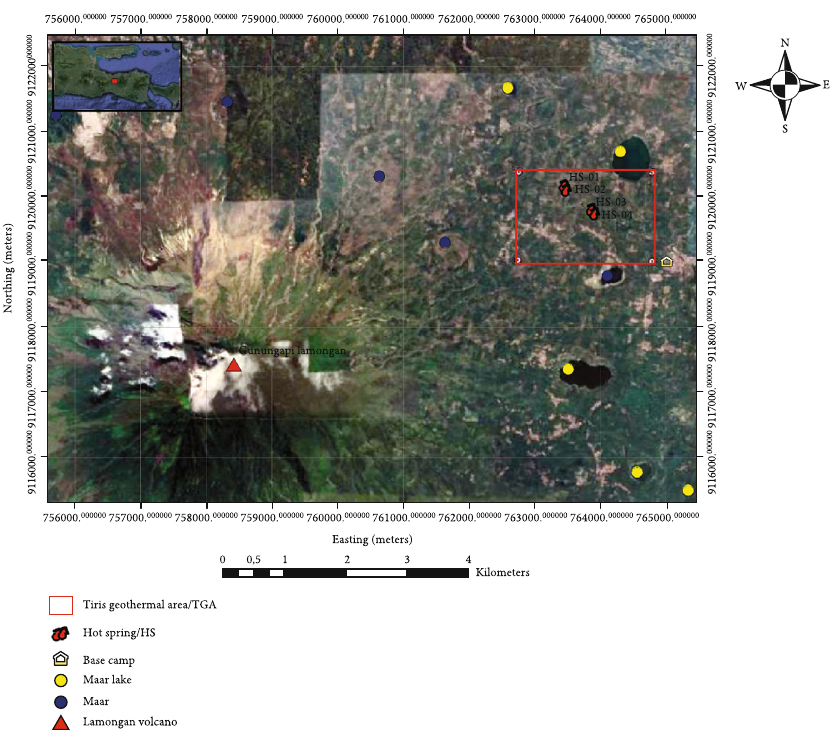
Figure 1: Research location map.